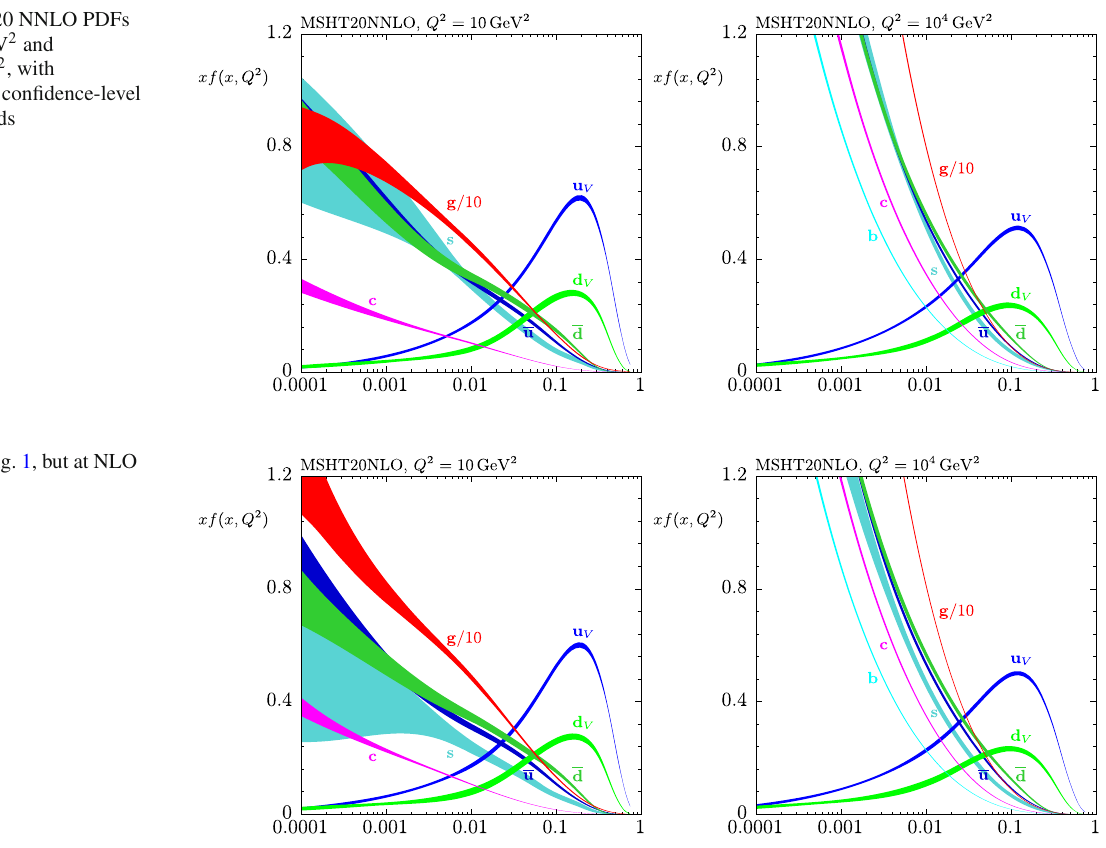
Fig. 1 MSHT20 NNLO PDFs at Q 2 = 10 GeV 2 and Q 2 = 10 4 GeV 2 , with associated 68% confidence-level uncertainty bands